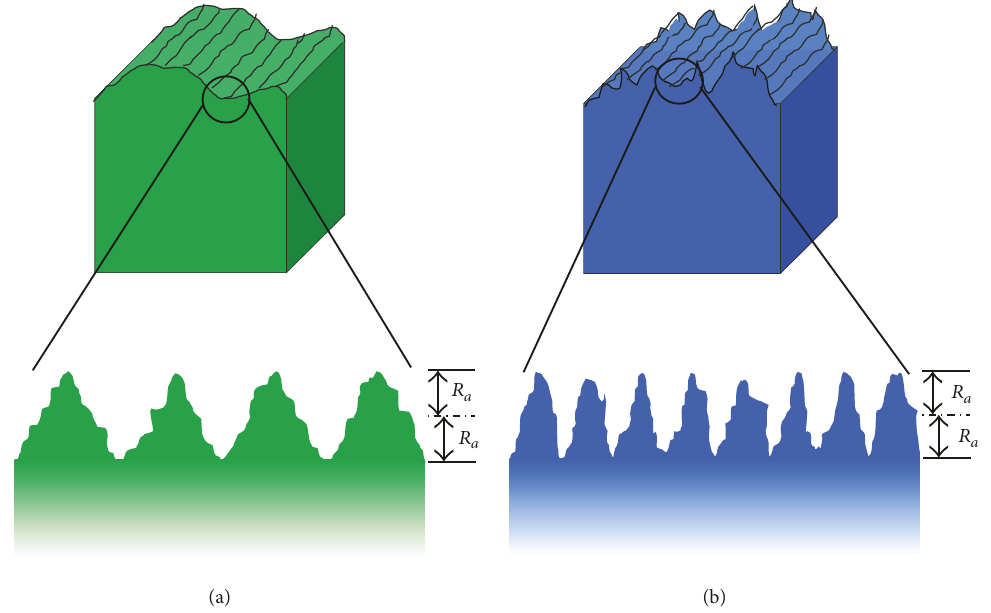
Scheme 1: Schematic illustration of different surface profiles having the same 𝑅 𝑎